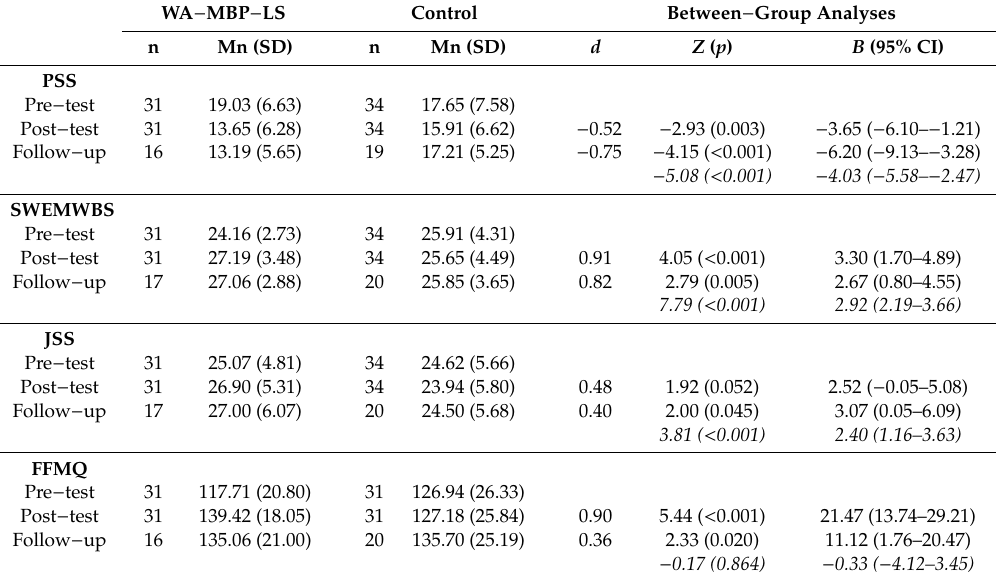
Between-group analyses of perceived stress, mental well-being, job satisfaction and